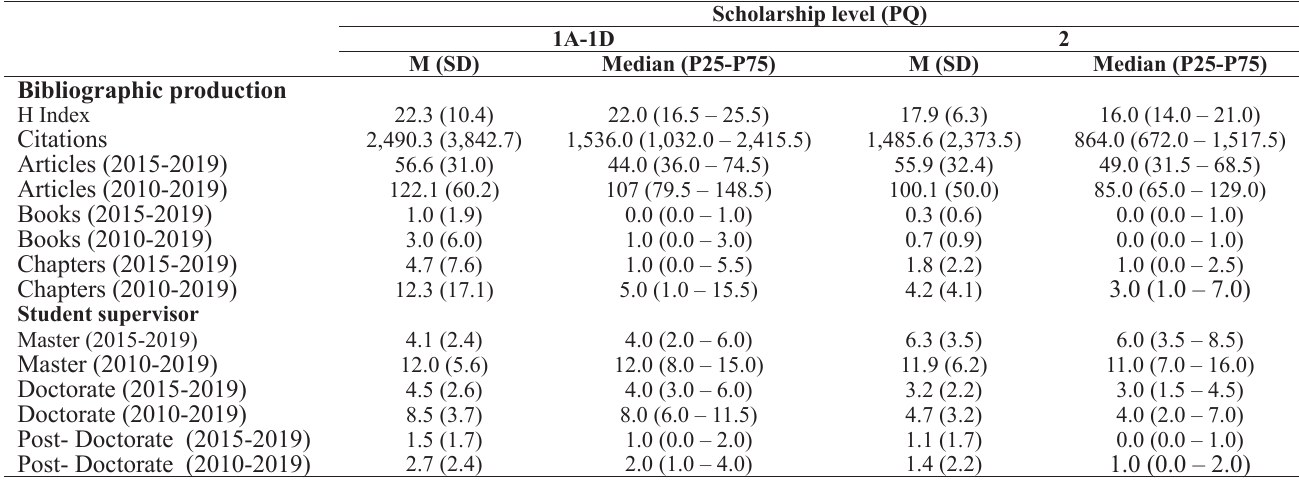
Table 2 - Average values, standard deviation, median and interquartile range of the bibliographic production and training of human resources indicators of CNPq Productivity Researchers in the field of Physical Education. Brazil.